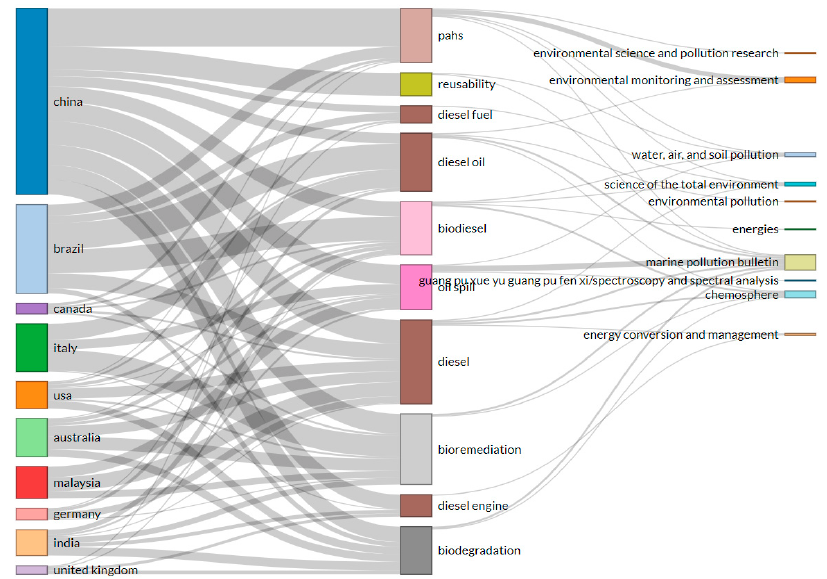
Figure 1. Relations between countries ( left ), author keywords ( middle ), and sources ( right ) repre- sented in a three-field-plot. PAHs: Polycyclic aromatic hydrocarbons.